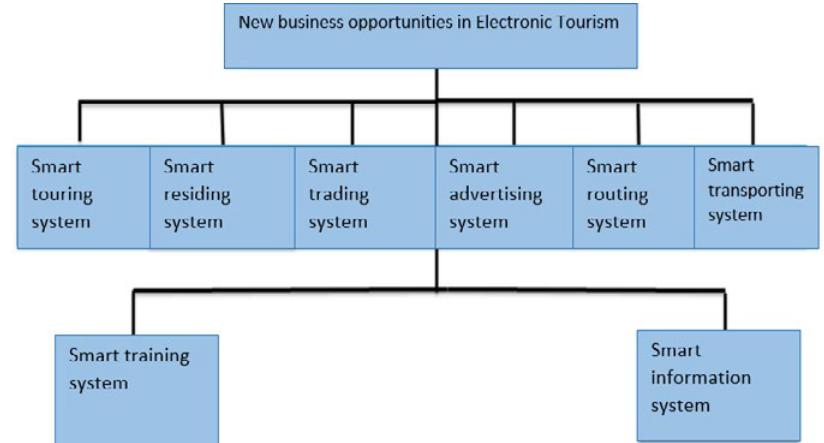
Fig. 6. Drawing hierarchy decision tree of new business opportunities in the electronic tourism industry from the south to the Oman sea and from the east to Pakistan, and from the west to the city of